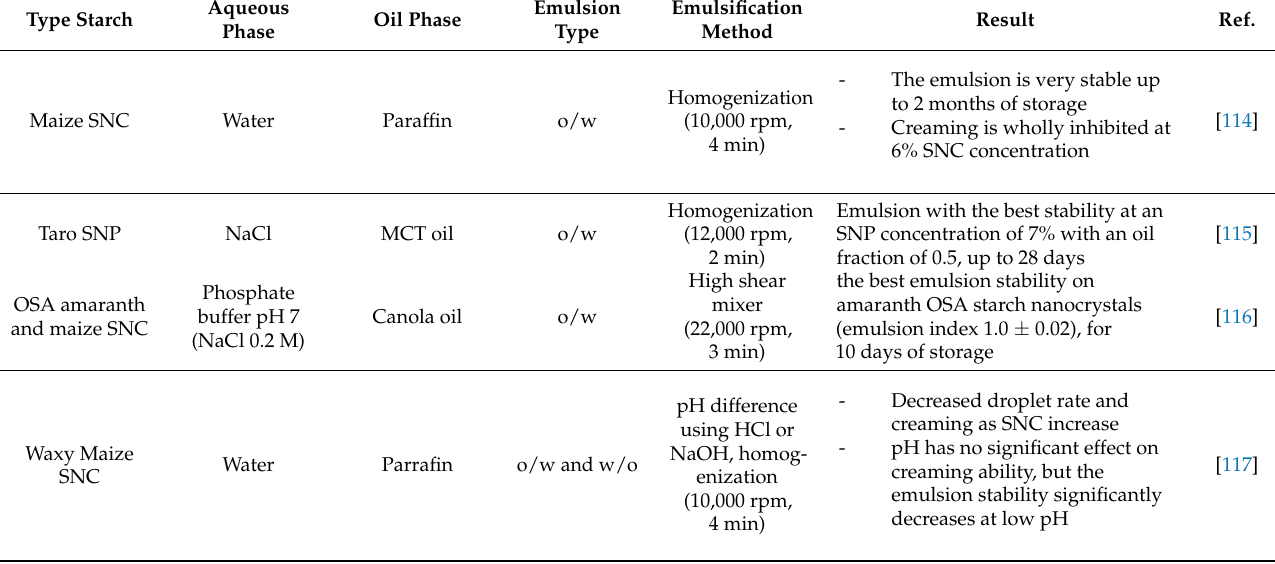
Table 5. Application of SNPs compared with SNCs as Pickering